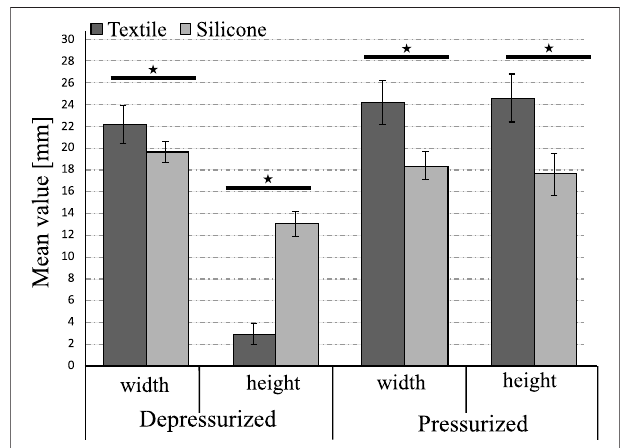
FIGURE 6 | Comparison of critical dimensions for wearable devices and their variation according to the actuation state in silicone and textile actuators. The symbol + represents a signi fi cant difference between the two groups based on statistical analysis tests ( p < 0.05). For all variables, there are signi fi cant differences in the change of state (depressurised, pressurised).